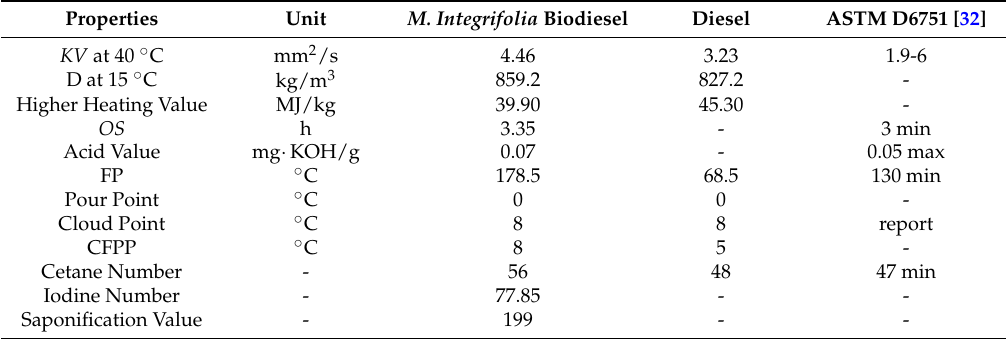
Table 4. Properties of macadamia biodiesel compared to other